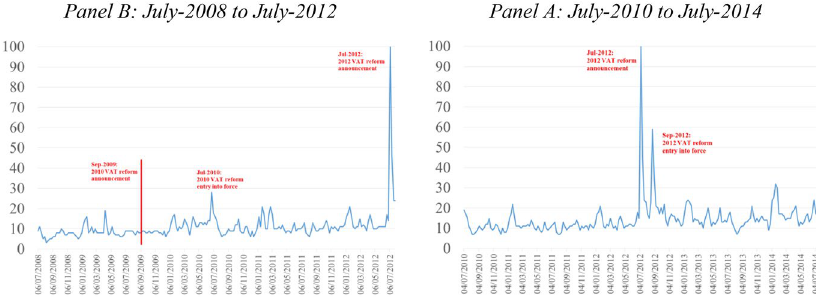
Fig. 3 Google searches for keyword “IVA” throughout the sample period (July 2008 to July 2014). Source : Google